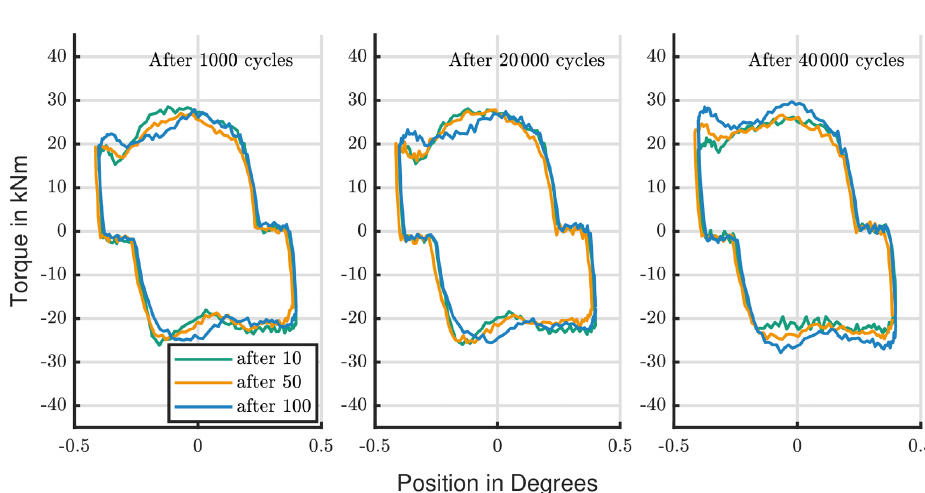
Figure 13. Test with protection run every 100 cycles.